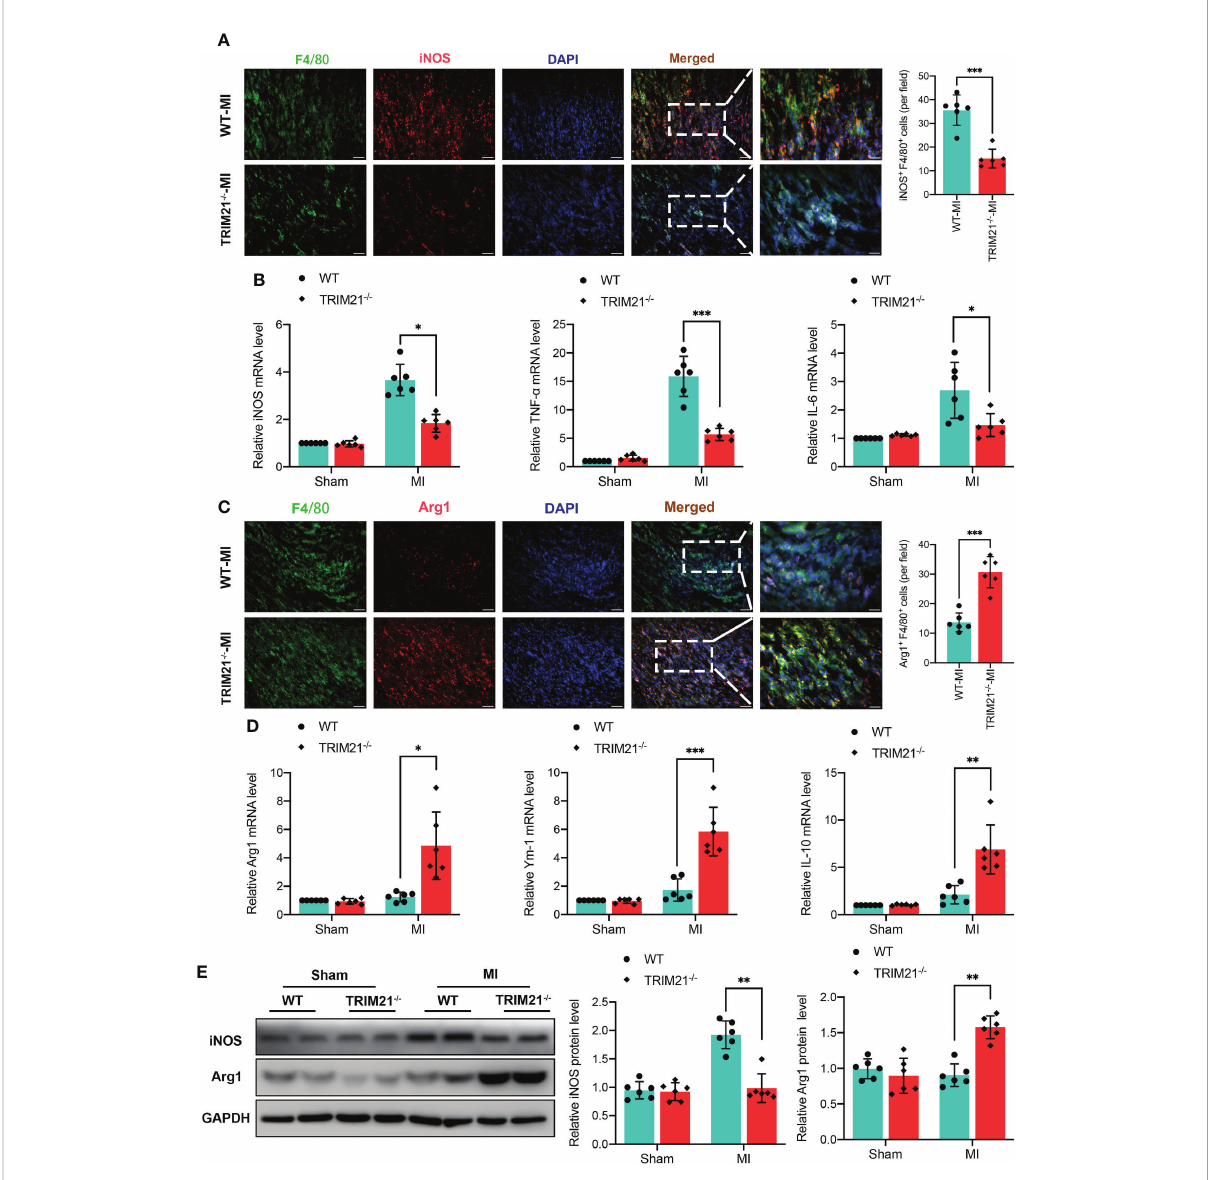
FIGURE 4 TRIM21 de fi ciency mediates macrophage polarization in the infarct infarcted zone at day 3 post ‐ MI. Representative double- fl uorescent immunostaining images of F4/80 and iNOS (A) and F4/80 and Arg1 (C) . The double ‐ positive iNOS and F4/80 (iNOS + /F4/80 + ) areas of M1 macrophages and Arg1 and F4/80 (Arg1 + /F4/80 + ) M2 macrophages were quanti fi ed (right) Scale bar:50 mm. (B) Gene expression of iNOS, TNF- a , and IL-6 in heart tissues isolated from infarct border zone at day 3 after MI. n = 2 mice/group pooled from 3 independent experiments. (D) Gene expression of Arg1, Ym-1, and IL-10 in heart tissues isolated from infarct zone at day 3 after MI. n = 2 mice/group pooled from 3 independent experiments. (E) iNOS and Arg1 protein expression at day 3 post-MI in the infarct zone isolated from WT and TRIM21 -/- mice. n = 2 mice/group pooled from 3 independent experiments. *P<0.05, **P<0.01, and